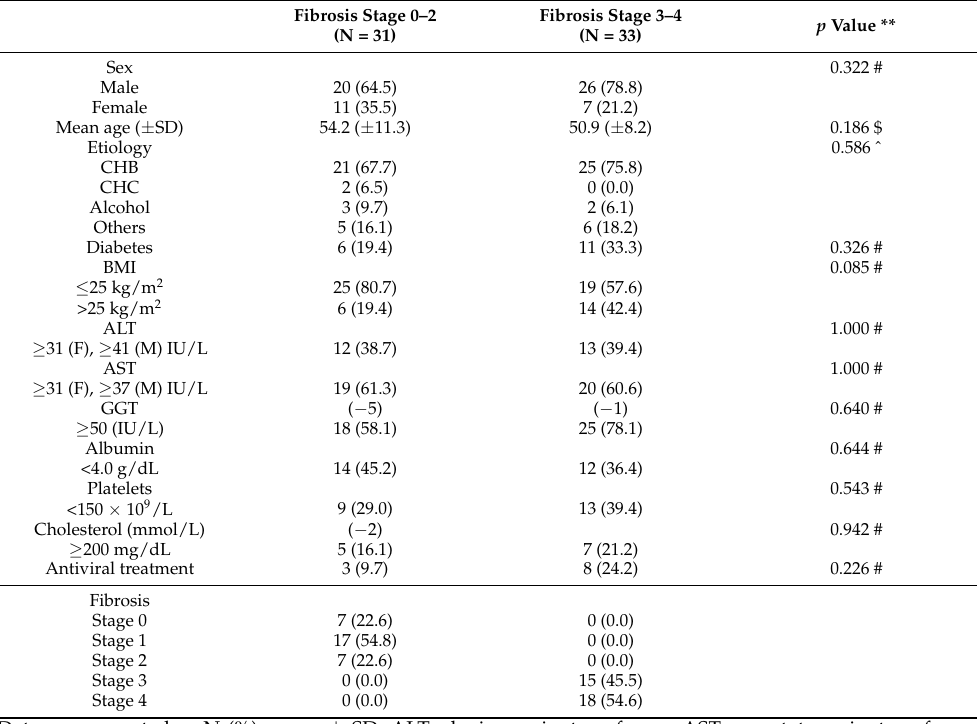
Table 1. Baseline characteristic of enrolled